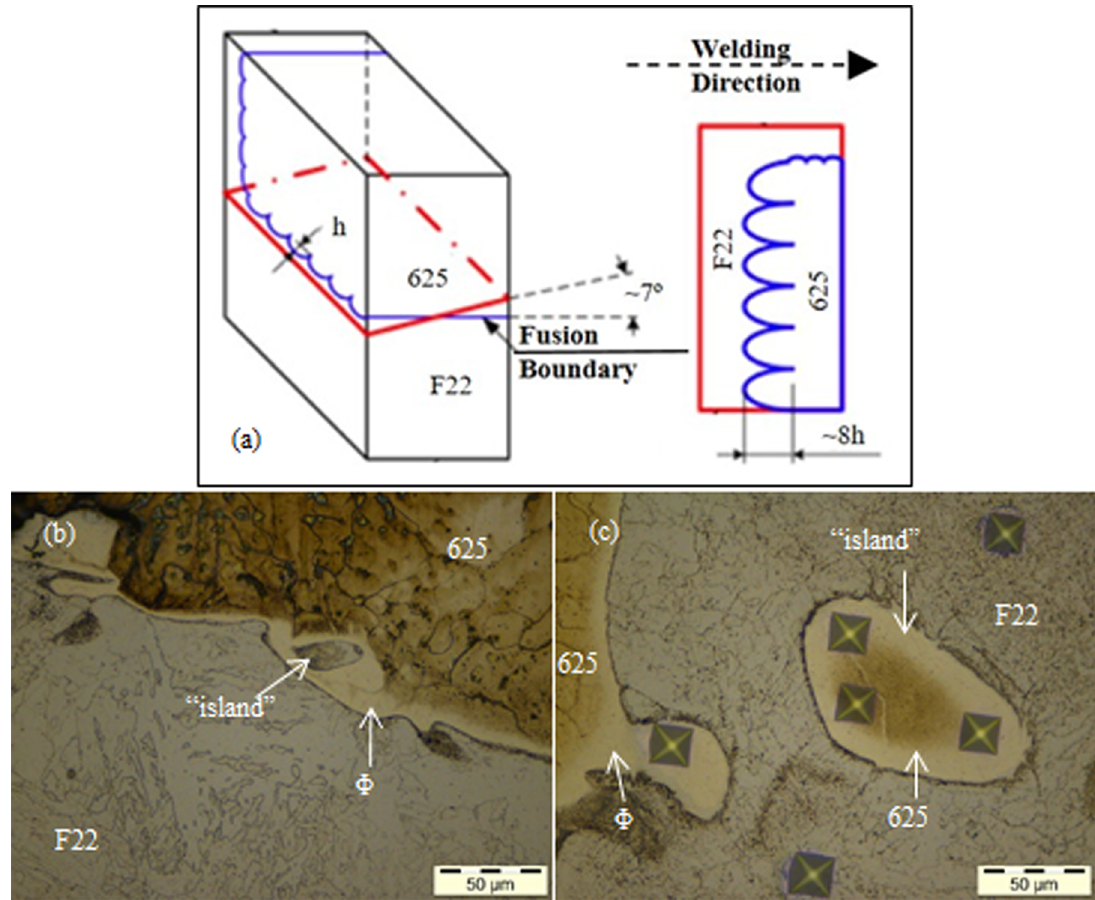
Figure 1. Samples (a) LAMS diagram 27. (b) NCS image. (c) LAMS